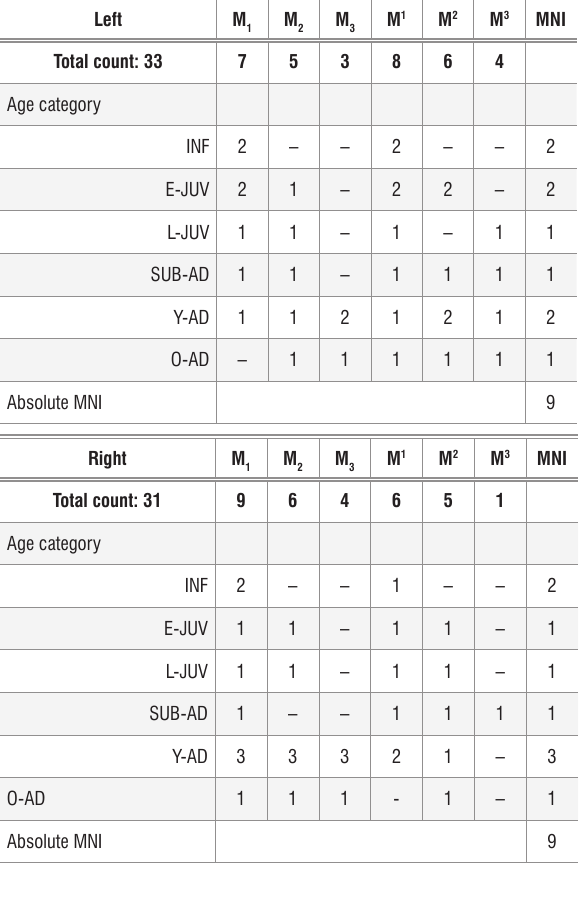
Table 2: Dental individuals as assessed from in-situ teeth, and with the number of associated molars identified. Dental individual 6 is repeated in the table because U.W.101-1261 preserves the mandibular and U.W.101-1277 the maxillary